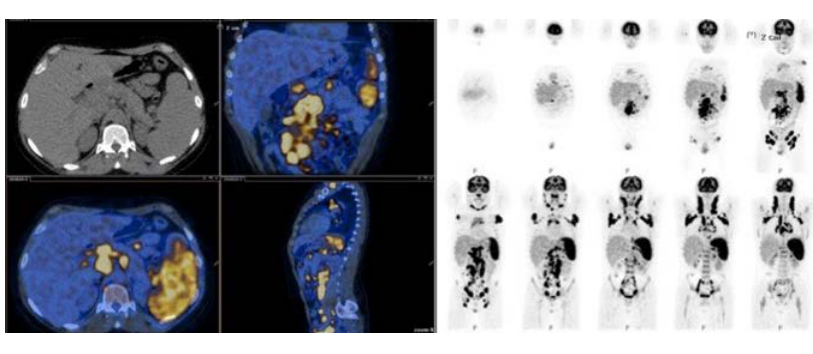
Figure 2. First patient’s FDG-PET/TC: disseminated disease with localization to the Waldeyer’s